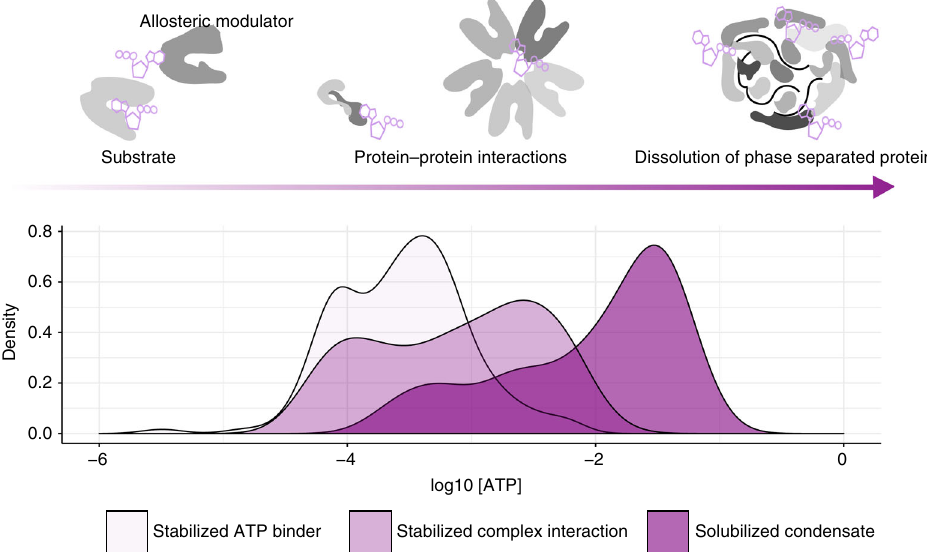
Fig. 6 Concentration-dependent proteome-wide effect of ATP. Density plots of pEC 50 s of ATP-stabilized ATP-binding proteins, complexes, as well as of proteins solubilized by ATP as measured by 2D-TPP and SPP technologies. Despite a clear difference in the distributions, there is a substantial overlap, showing that changes in ATP concentrations will have simultaneous effects on the stability of ATP-binding proteins and complexes as well as on the solubility of disordered proteins